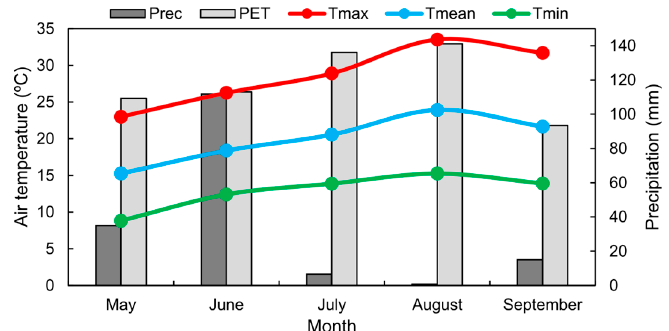
Figure 2. Monthly mean values for maximum (Tmax), mean (Tmean), and minimum (Tmin) air temperatures; precipitation (Prec); and potential evapotranspiration (PET) for the studied area in the period ranging from May to September 2018.